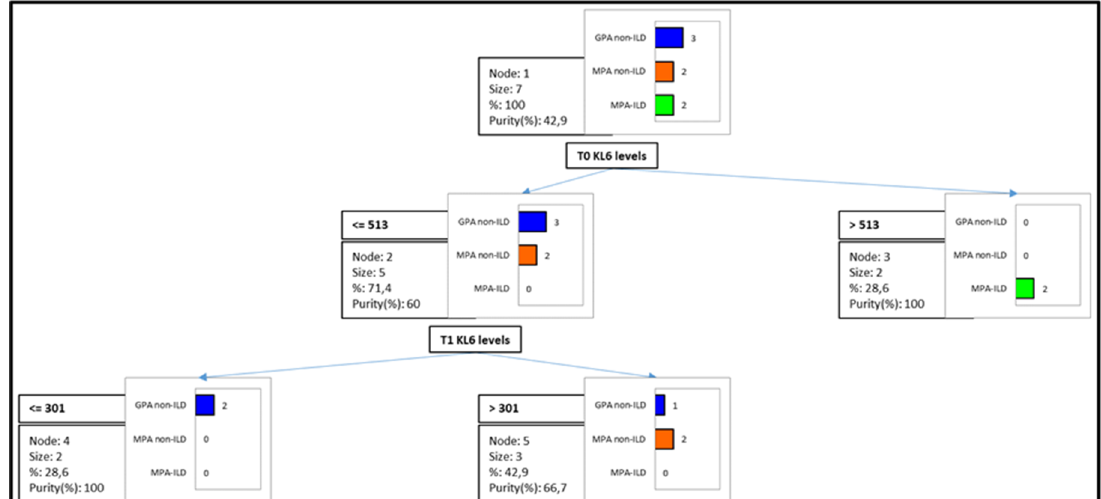
Figure 2. A decision tree model (and cross-validation by confusion matrix) was applied to T0 and T1 KL-6 concentrations in AAV patients stratified as MPA and GPA with and without ILD. The model obtained an improvement of 57.1% for classifying MPA-ILD patients with a serum T0 KL-6 cut-off of 513 U/mL and 40% of improvement for classifying GPA non-ILD with a T0 serum KL-6 cut-off value of 513 U/mL and a T1 KL-6 cut-off of 301 U/mL.